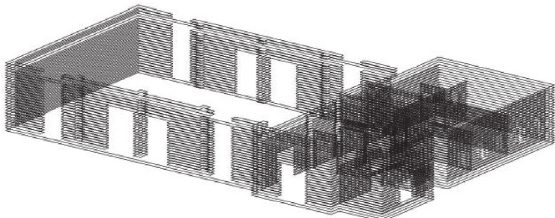
Figure 18: The layers of Ras Alain Multipurpose